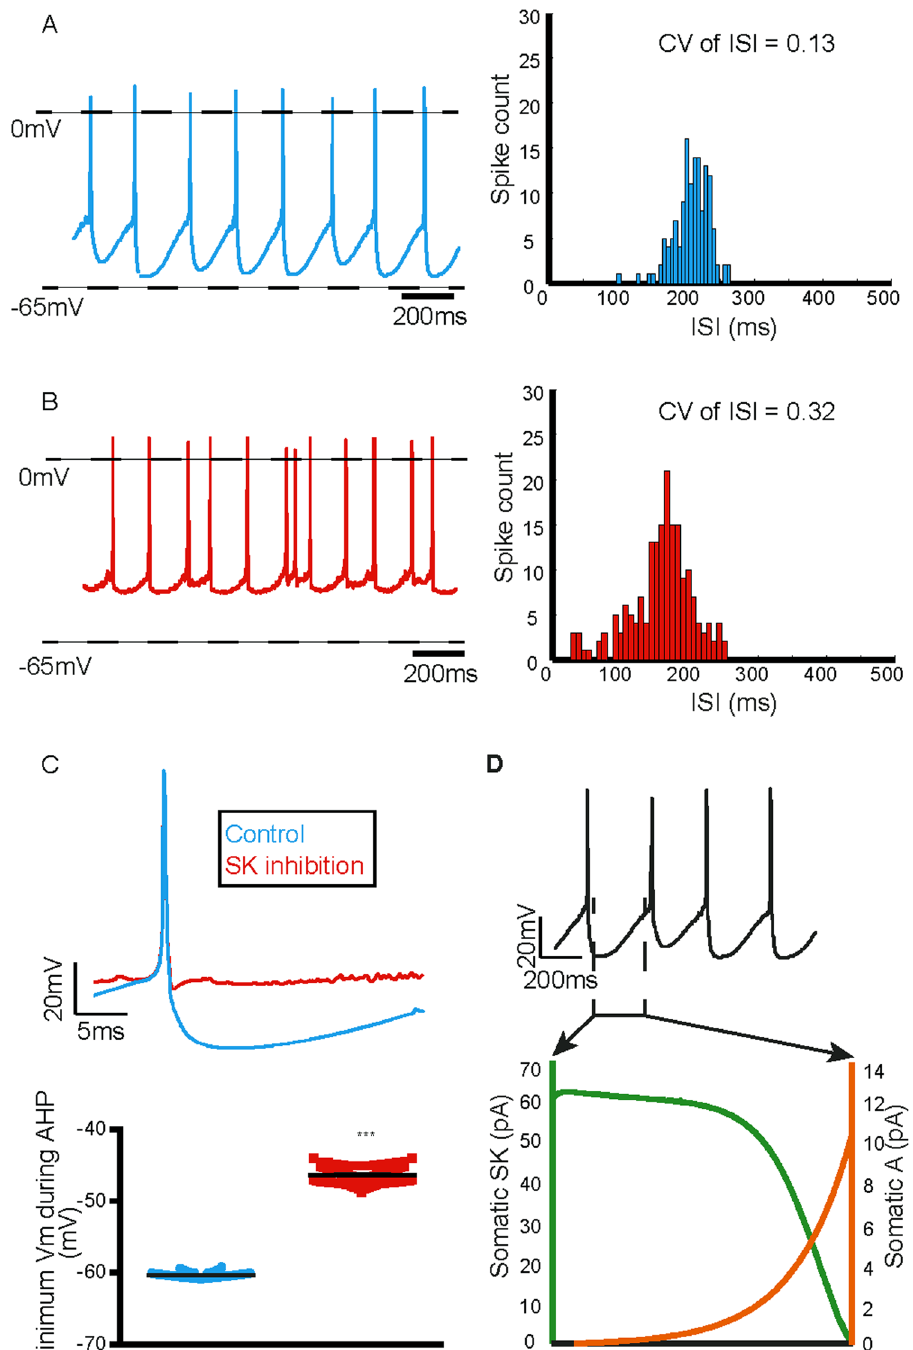
Figure 4. Simulated inhibition of SK channels decreases firing regularity and increases firing rate. ( A ) The model dopamine neuron fired spontaneously at a slow and rhythmic rate of 3.6 Hz ( left ) with CV of ISI = 0.13 ( right ). ( B ) Simulated SK channel inhibition resulted in a decrease in the firing regularity ( left ) and the CV of ISI increased to 0.32 ( right ). ( C ) This was accompanied by a decrease in the AHP of the action potential ( top ), quantified by a significant decrease in peak AHP ( bottom ). ( D ) Somatic currents prominent during the ISI. Error bars represent mean ± S.E.M, not visible due to small